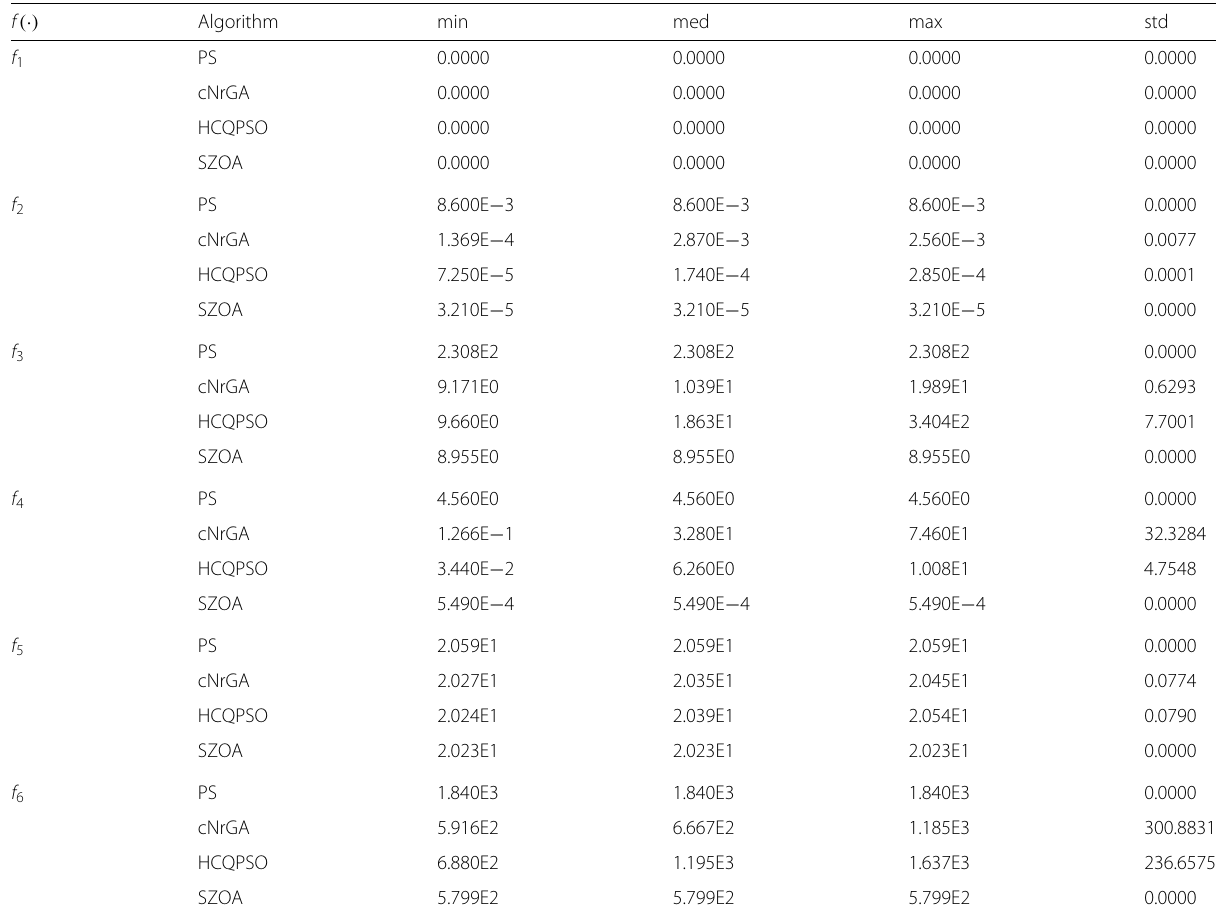
Table 2 Optimal function values found by PS, cNrGA, HCQPSO, and SZOA over 25 independent runs